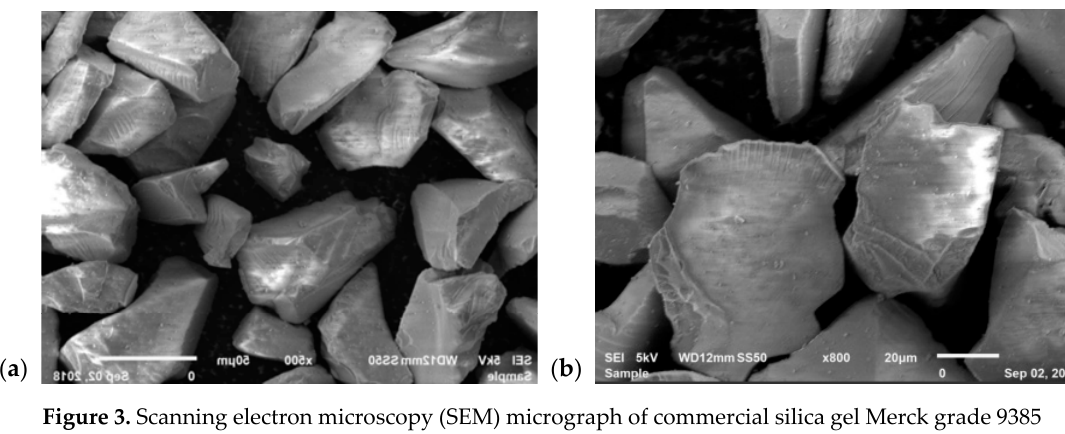
Figure 3. Scanning electron microscopy (SEM) micrograph of commercial silica gel Merck grade 9385 ( a , left) and 10X recycled silica gel Merck grade 9385 ( b ,